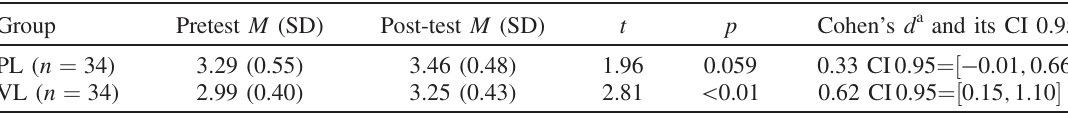
TABLE IV. Means, standard deviations, and comparisons of SISE. Group Pretest M (SD) Post-test M (SD)